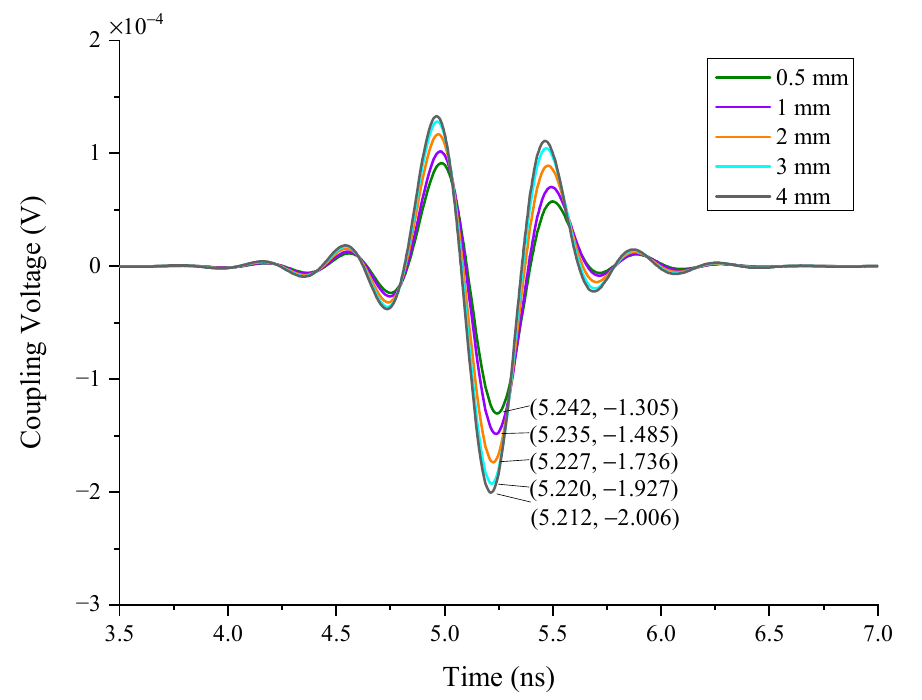
Figure 22. The responses of different distances among the wires.